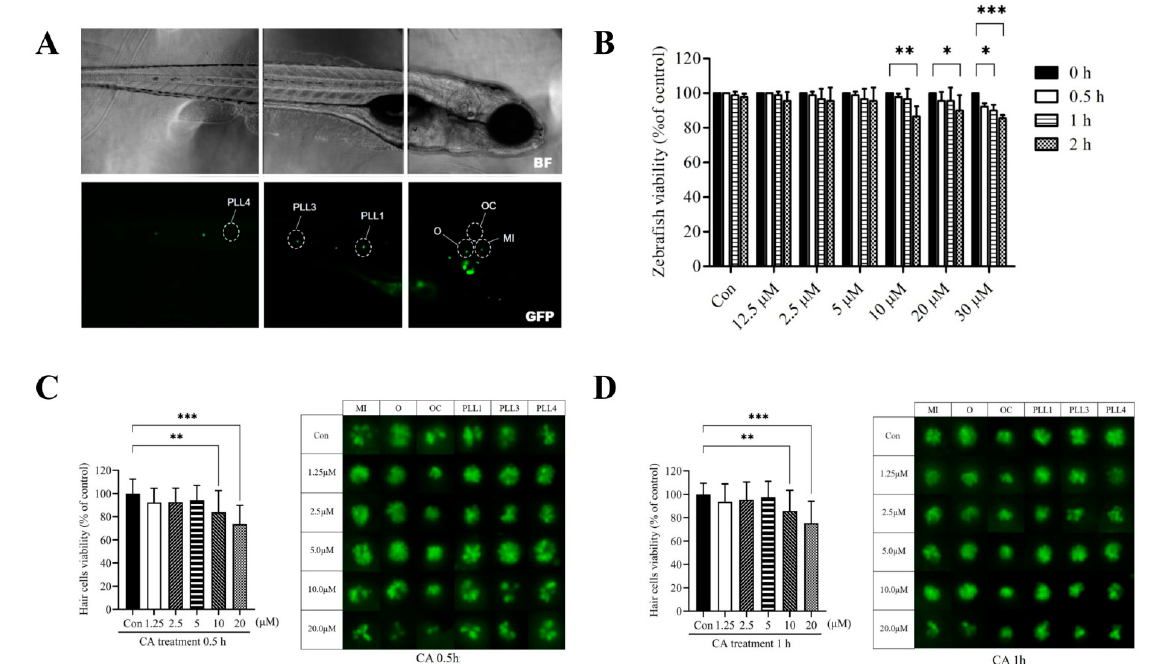
Figure 1. Effects of CA on transgenic zebrafish larvae and hair cell viability. ( A ) Fluorescence micrograph of a 7-dpf transgenic zebrafish larvae. The analyzed lateral line hair cells in zebrafish are marked by a white circle: otic (O), occipital (OC), middle (MI), and posterior lateral line (PLL1, PLL3, and PLL4). Scale bar: 100 μ m. ( B ) 7-dpf transgenic zebrafish larvae were treated with CA (0, 1.25, 2.5, 5, 10, 20, and 30 μ M) for different time (0.5, 1, and 2 h). After the exposure period, viable fish were counted and presented as a percentage of the untreated control. ( C ) Lateral line hair cells were treated with CA (0, 1.25, 2.5, 5, 10, and 20 µ M) for 0.5 h and ( D ) 1 h. Fluorescence micrographs of lateral line hair cells from neuromasts (O, OC, MI, PLL1, PLL3, and PLL4) (right panel) were analyzed and panel). All values of the experimental groups were presented as mean ± SD. * p < 0.05, ** p <